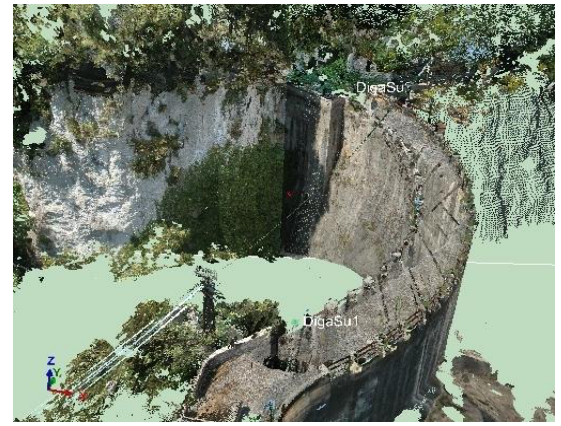
Figure 9. A view of true color 3D point cloud (RGB)